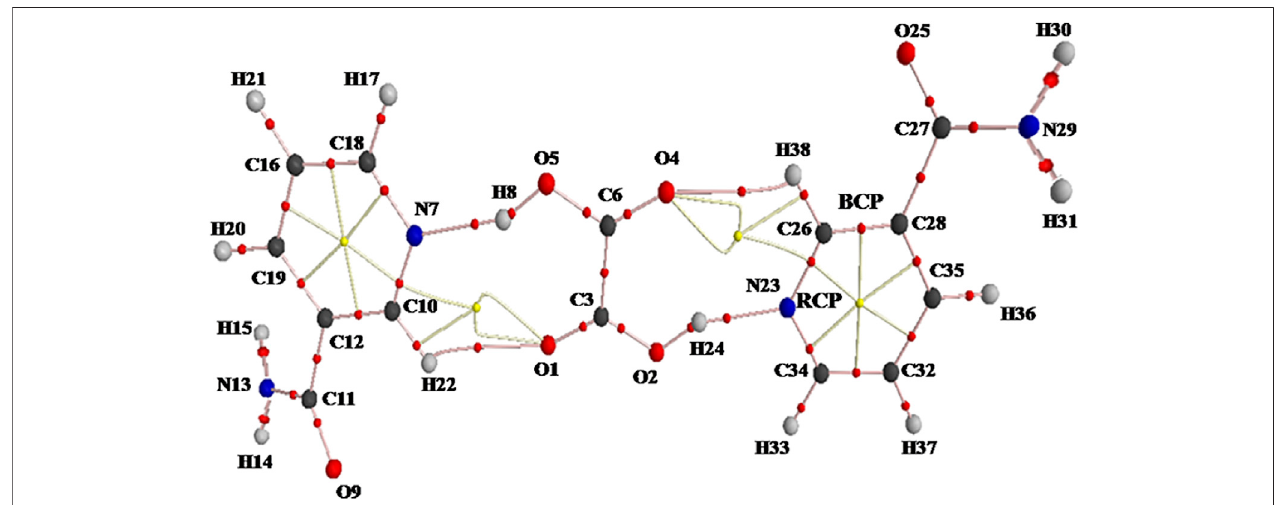
TABLE 2 | Geometrical parameter (bond length) and topological parameters for bonds of interacting atoms of intermolecular hydrogen bonding of NIC – OXA salt: electron density ( ρ